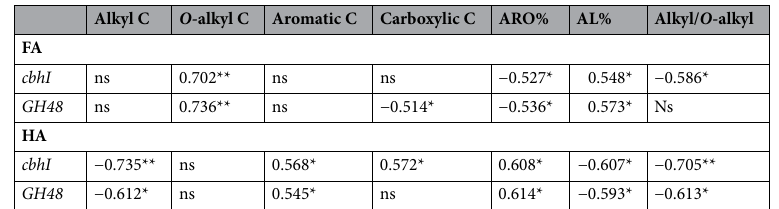
Table 4. Correlation coefficients between chemical compositions of C groups of FA and HA with abundance of cbhI and GH48 genes in different particle-size fractions under different fertilizer treatments. ns no significant relationship were detected. * p < 0.05; ** p <